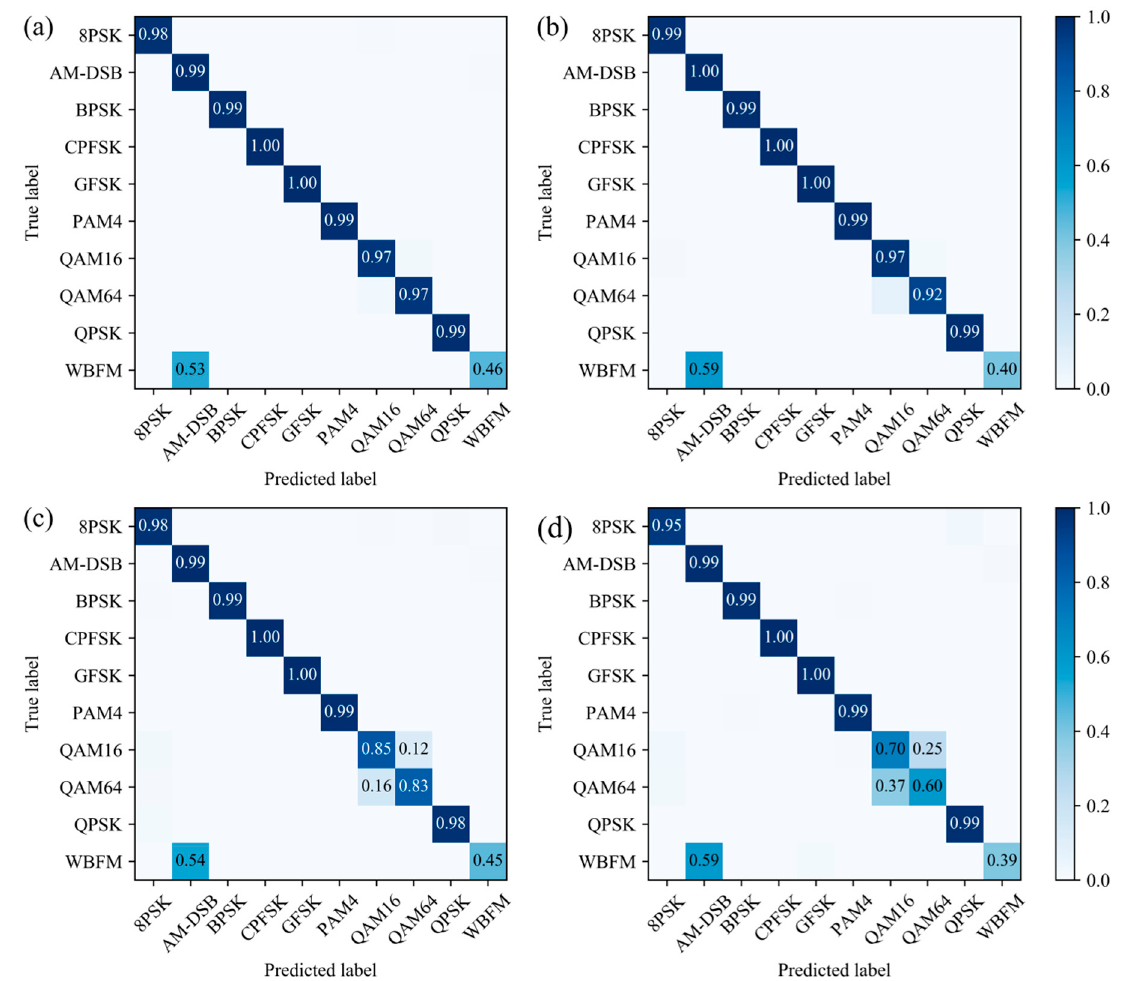
Electronics 2023 , 12 , x FOR PEER REVIEW Figure 12. Confusion matrix of network structures under different data augmentation methods with SNRs of 18 dB: ( a ) scaling; ( b ) magnitude warping; ( c ) time warping; ( d ) original training set.